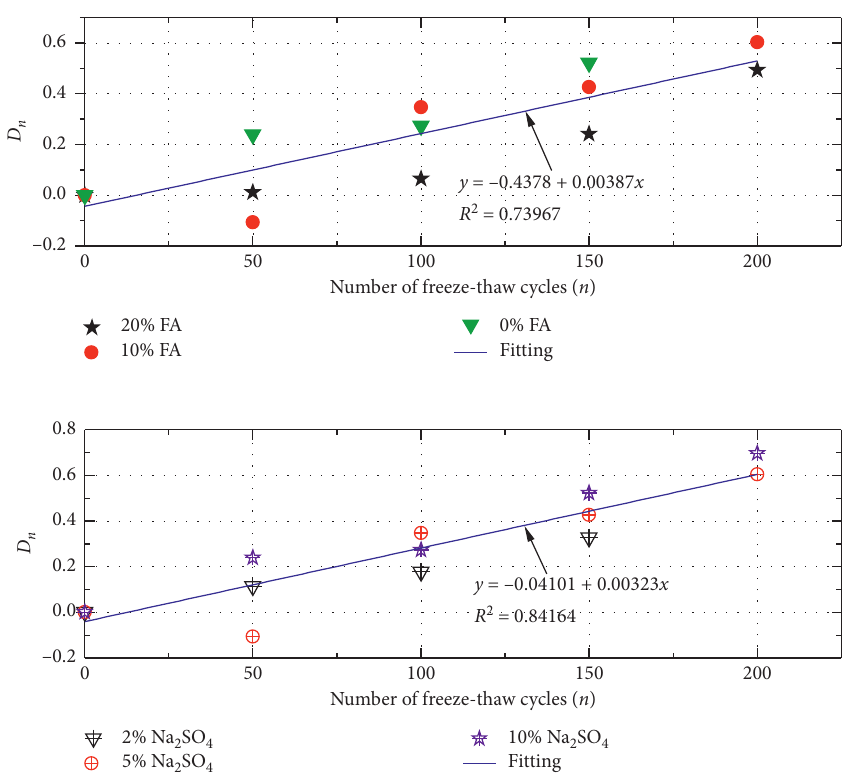
Figure 8: Relationship between D n and coupling cycles. Table 5: Element content of corrosion